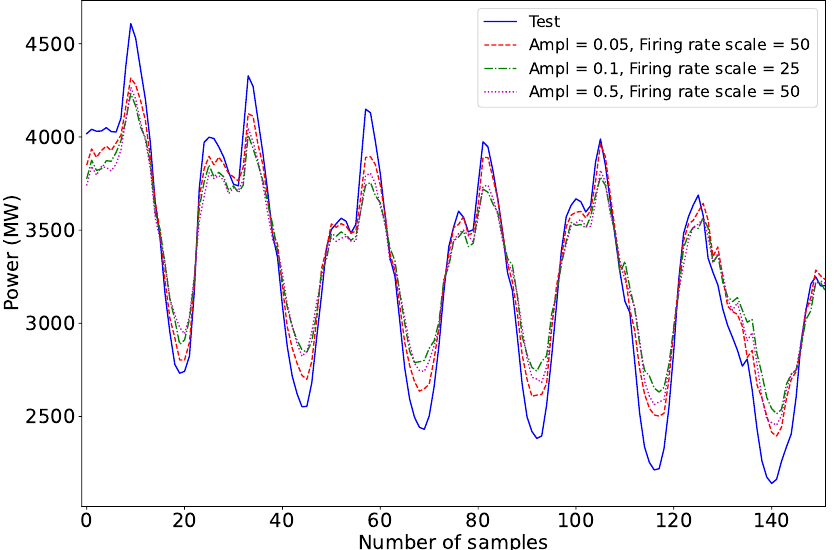
Figure 5. Preliminary one-step-ahead load forecasts, setting different spike amplitudes and firing rates.